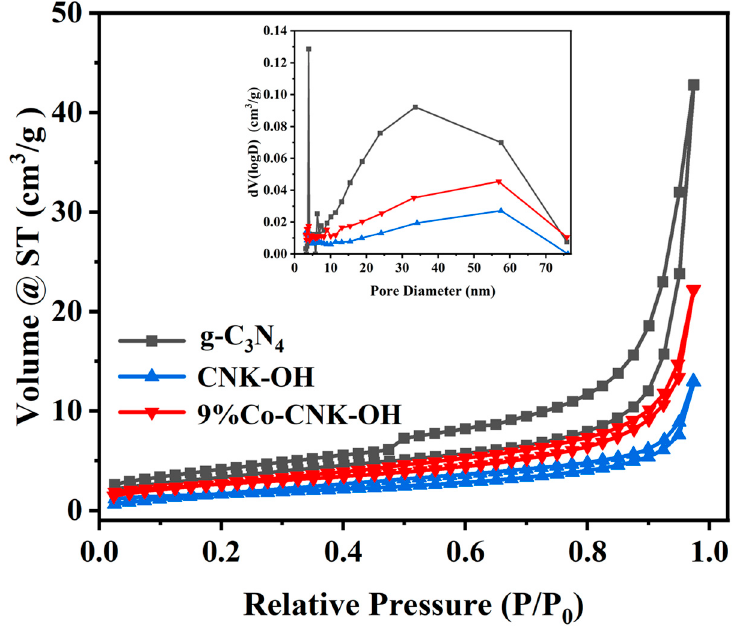
Figure 5. Nitrogen adsorption-desorption isotherms (outer figure) and corresponding pore-size distribution curves (sub- fi gure) for g-C 3 N 4 , CNK-OH and 9%Co-CNK-OH.